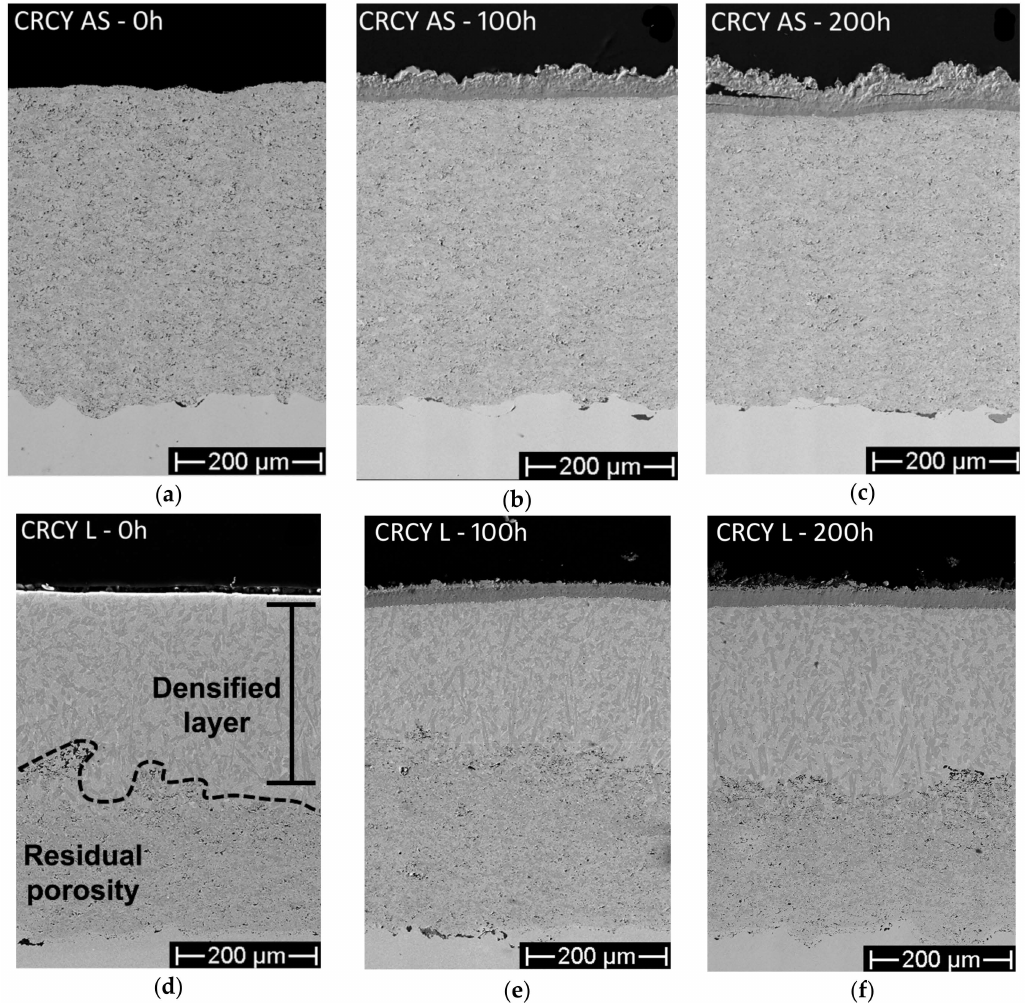
Figure 4. Cross-sections of the CRCY samples: ( a ) As-sprayed; ( b ) as-sprayed after 100 h of hot corrosion test; ( c ) as-sprayed after 200 h of hot corrosion test; ( d ) laser-treated; ( e ) laser-treated after 100 h of hot corrosion test; and ( f ) laser-treated after 200 h of hot corrosion test.